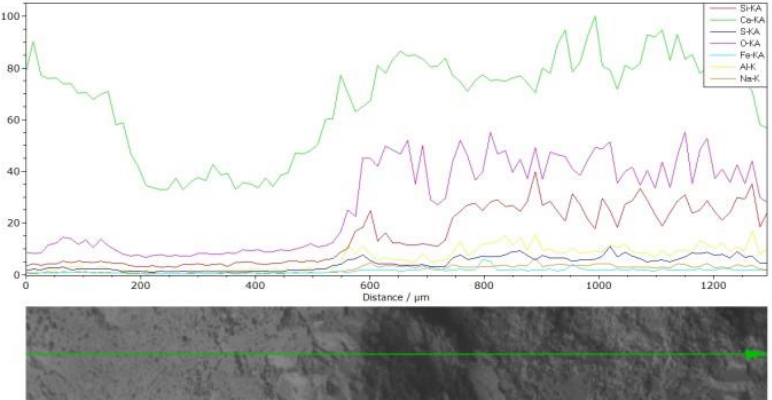
Figure 8. SEM images at 1200 magnifications and composition analysis .